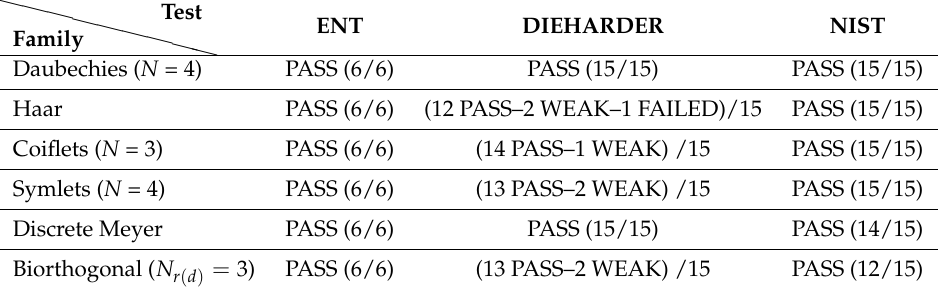
Table 7. Wavelet family